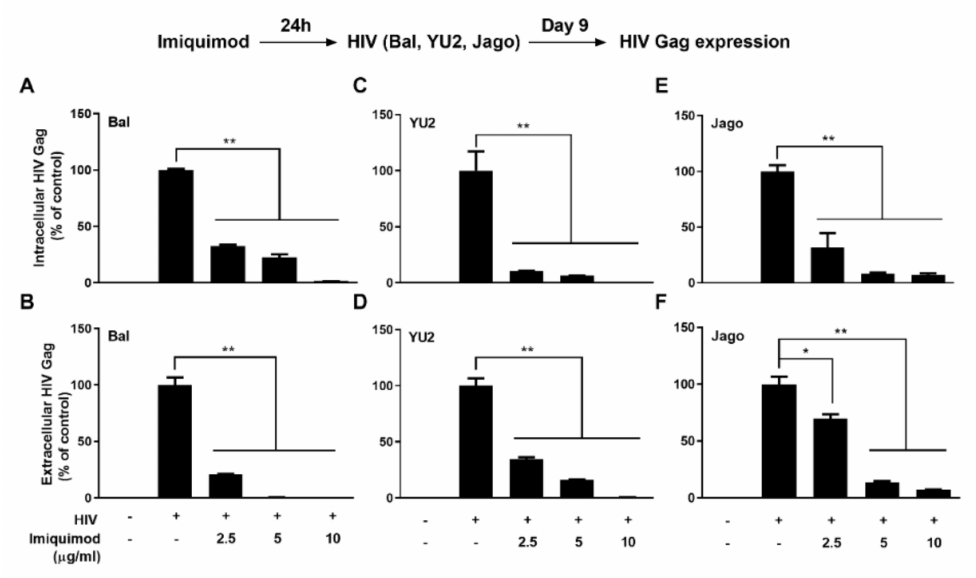
Figure 1. Imiquimod inhibits HIV Gag gene expression. ( A – F ) Macrophages were treated with or without imiquimod at indicated concentrations for 24 h prior to HIV (Bal, YU2, and Jago) infection. Cellular and culture supernatant RNAs were collected on day 9 post-infection and subjected to the real-time PCR for HIV Gag gene expression. Data are shown as mean ± SD of 3 independent experiments (* p < 0.05, ** p <